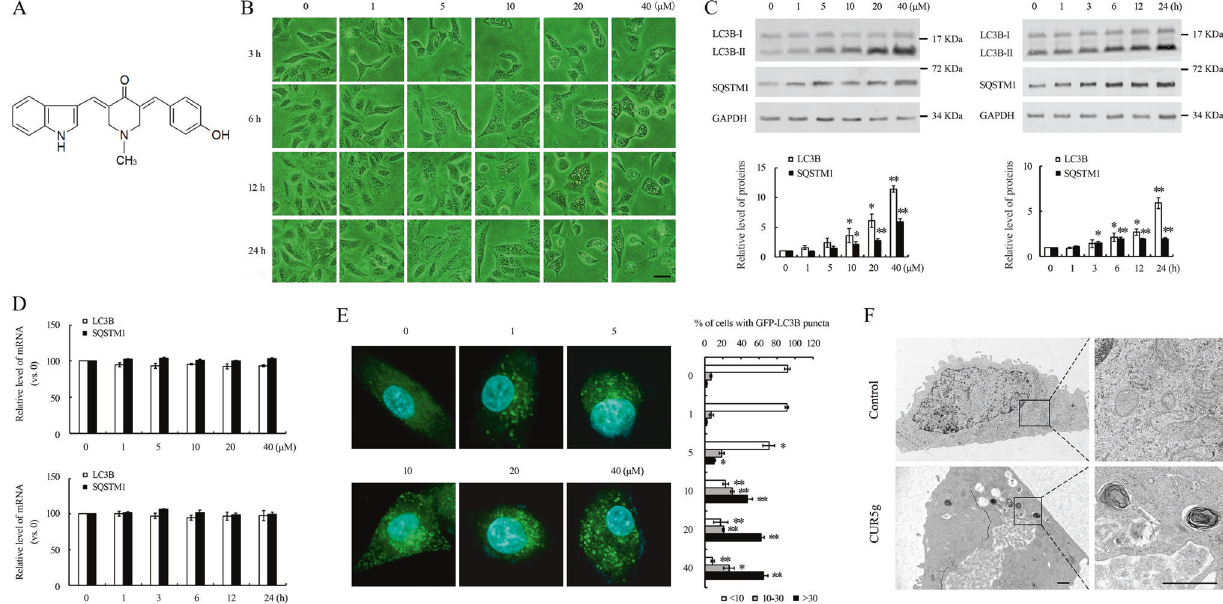
Fig. 1 CUR5g modulates autophagy in A549 cells. A The chemical structure of CUR5g. The molecular formula of this compound is C 22 H 20 N 2 O 2 , and its molecular weight is 344.41 g/mol. B Representative microscopy photographs of A549 cells treated with various doses (0 – 40 μ M) of CUR5g for 3 – 24 h. Scale bar = 40 μ m. C Western blot analysis of LC3B-II and SQSTM1 levels in A549 cells treated with various doses (0 – 40 μ M) of CUR5g for 24 h, or in the cells treated with 10 μ M CUR5g for 0 – 24 h. GAPDH was used as a loading control. ( n = 3; * p < 0.05, ** p < 0.01 vs. 0). D qRT-PCR analysis of LC3B and SQSTM1 mRNA levels. E Representative fl uorescence photographs of GFP-LC3B puncta